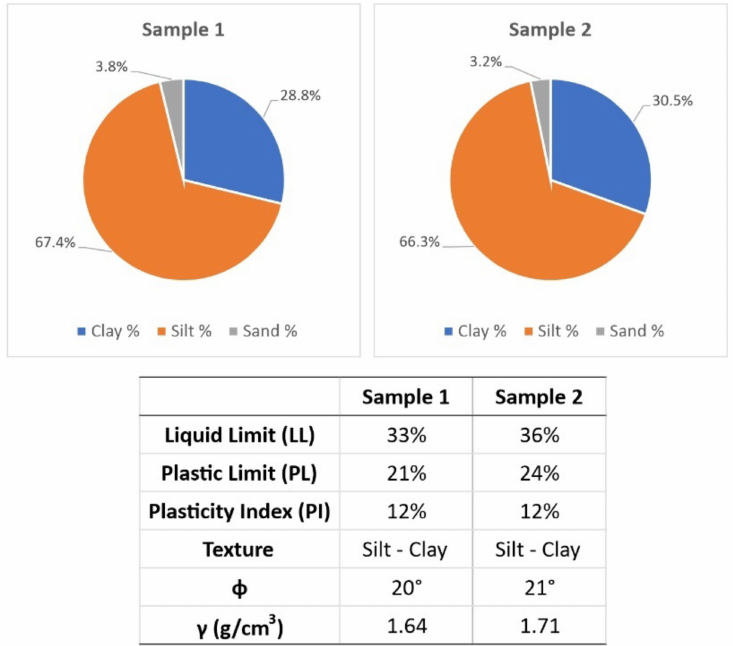
Figure 9. Geotechnical and sedimentological characteristics of two samples of sediment taken from the basin (see Figure 3 for the location).